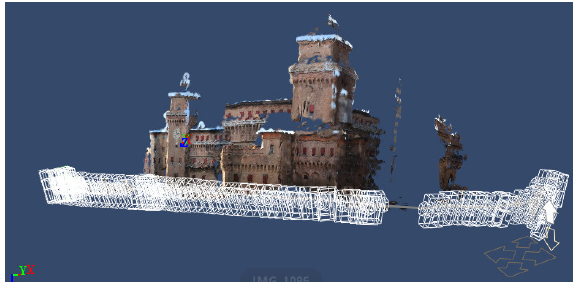
Figure 14. Estense Castle, Ferrara, Automatic Reconstruction (50% of pictures taken)